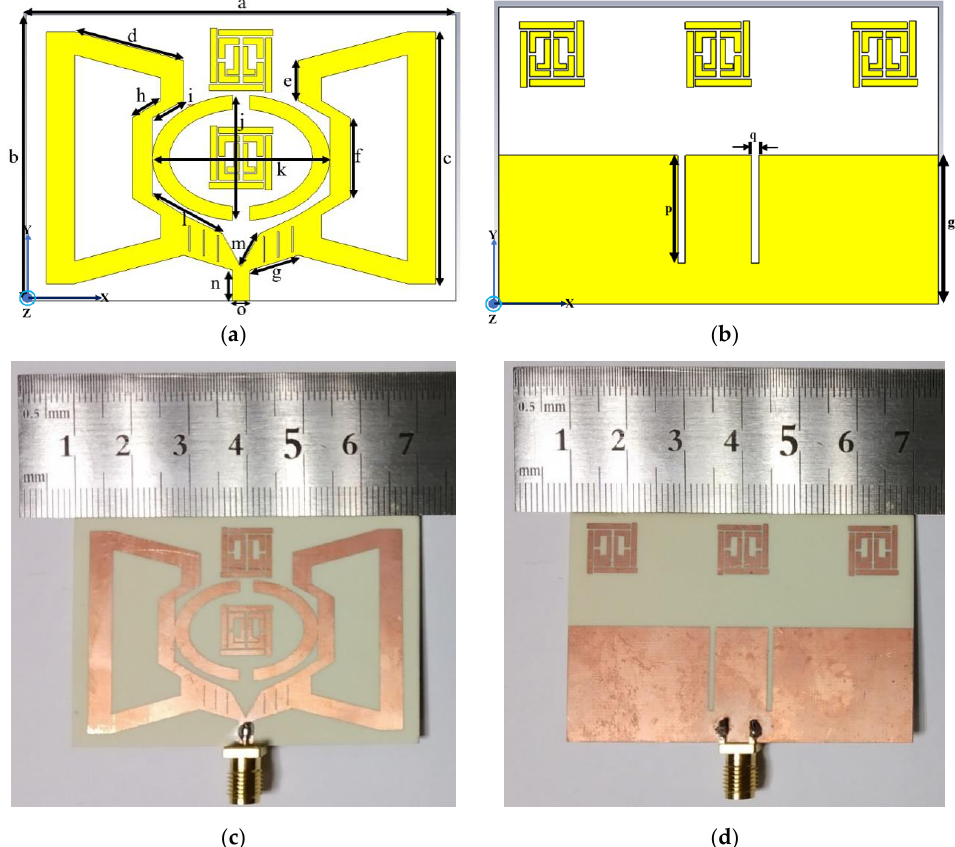
Figure 1. Proposed VMA design geometry ( a ) front view ( b ) bottom view; fabricated front ( c ) and bottom ( d ).